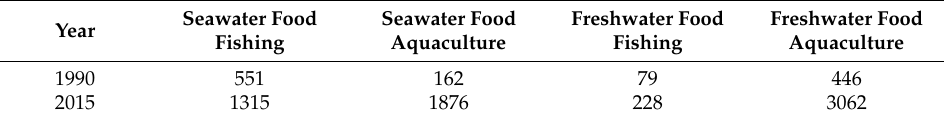
Table 1. Water food production in China in 1990 and 2015 (10 4 Ton).